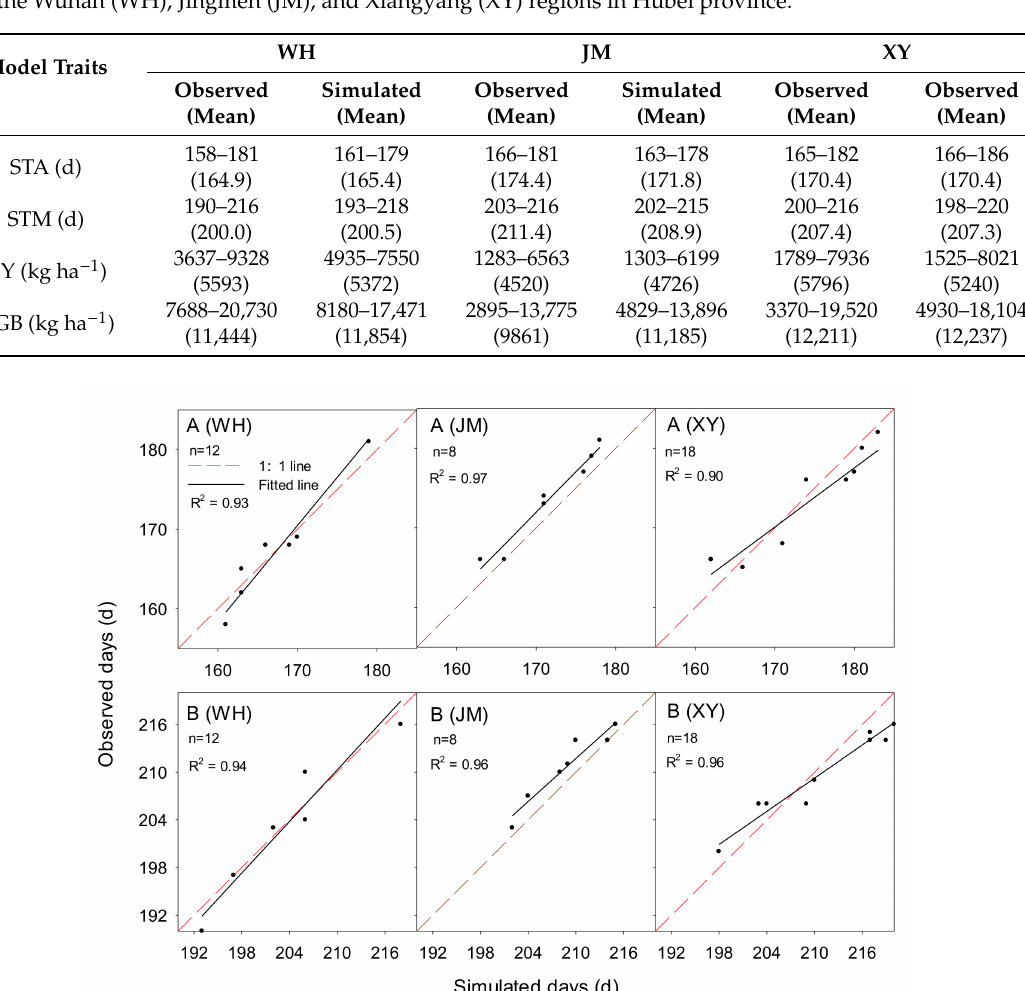
Figure 2. Relationships between simulated and observed growth durations from sowing to anthesis ( A ) and sowing to maturity ( B ) of winter wheat at Wuhan (WH), Jingmen (JM), and Xiangyang (XY)regions in Hubei province. Note: n means the number of paired data points, some points overlap, so the actual number of points in some graphs di ff ers from the value of n. R 2 is presented for the fitted